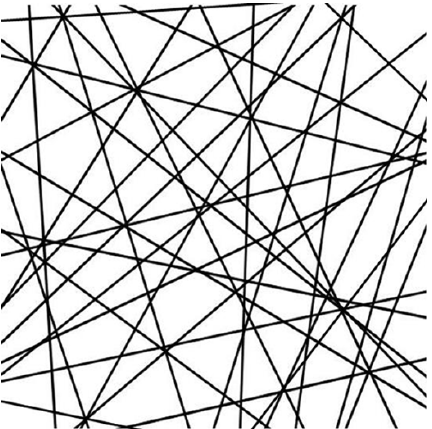
Figure 1. Schematic diagram of electrospun nanofiber membrane.